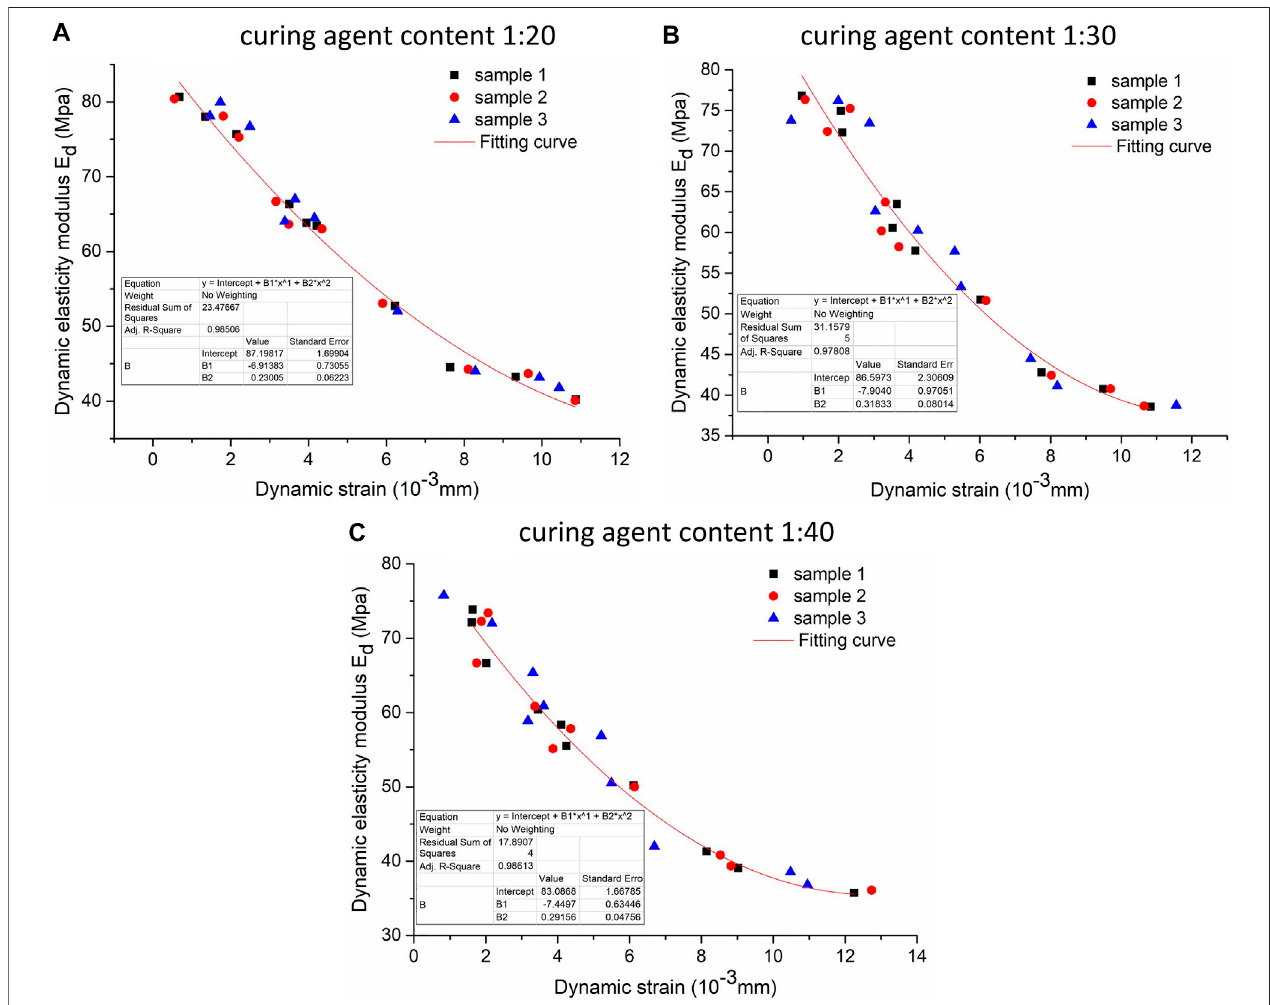
FIGURE 4 | Ed- ε d relation curve under dynamic load amplitude N (cid:1) 100N and different loading stages, Different cement content.